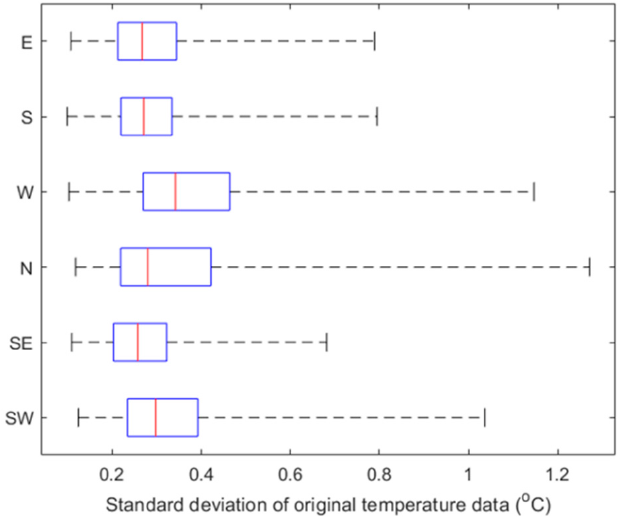
Figure 5. Boxplot of the daily SST standard deviation in 2018 in the study areas. The dashed line represents the standard deviation range. The blue box represents the range between the first and third quartiles and the red line in the box is the median.